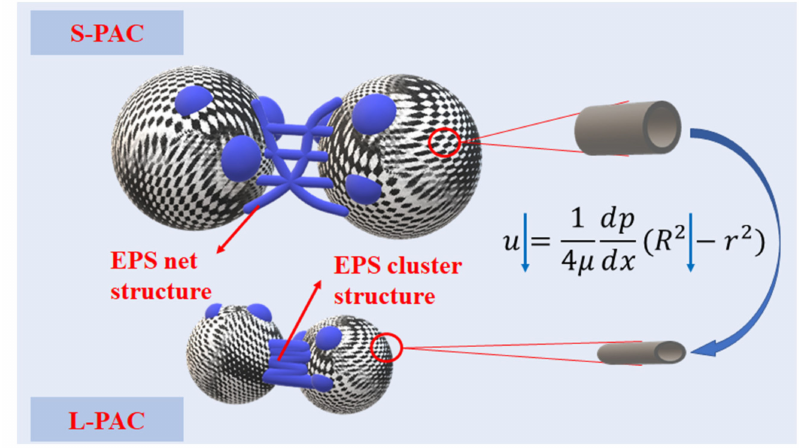
Figure 9. Mechanism of PAC addition on the UF filtration process.